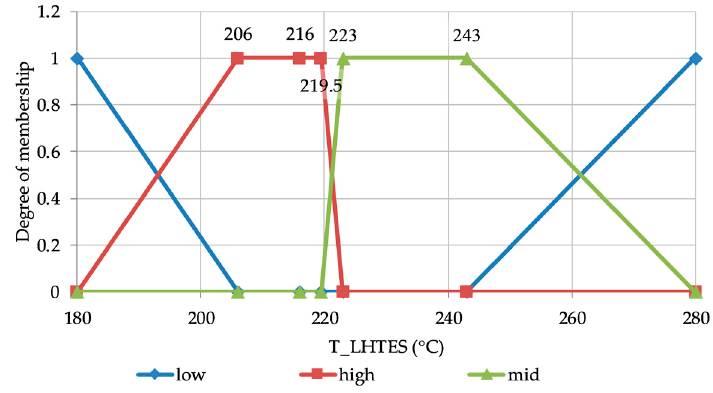
Figure 6. Sub-LHTES charging priorities.